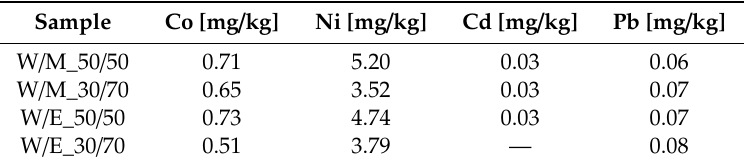
Table 4. Concentrations of metals(II) in extract samples.